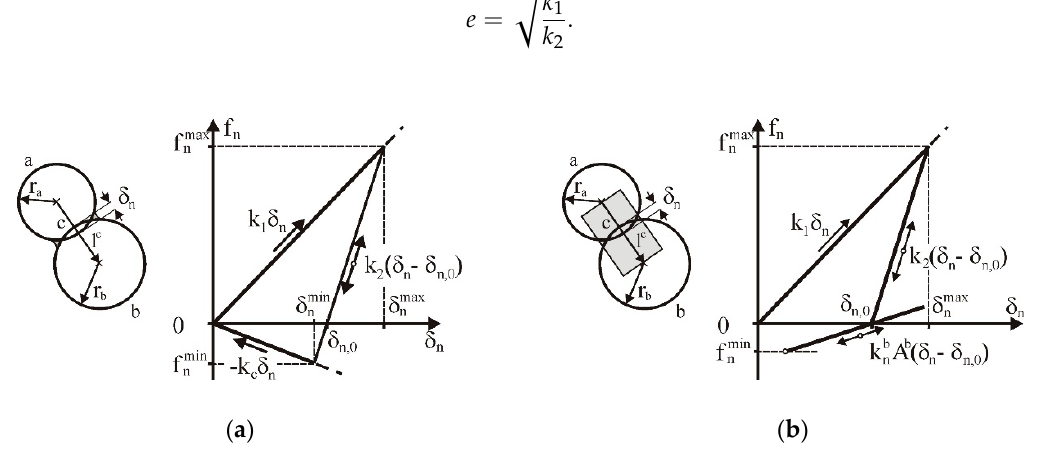
Figure 2. Constitutive linear elastic–plastic contact models: ( a ) linear adhesion model following concept of Luding [35], ( b ) parallel BPM.